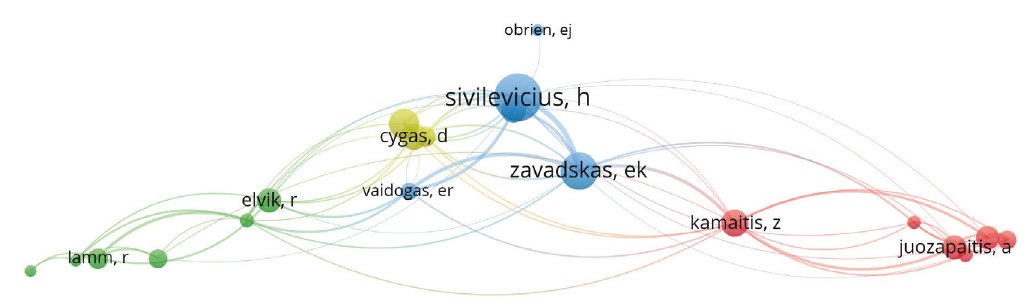
Figure 8. Co-citation network of authors cited by the Baltic Journal of Road and Bridge Engineering